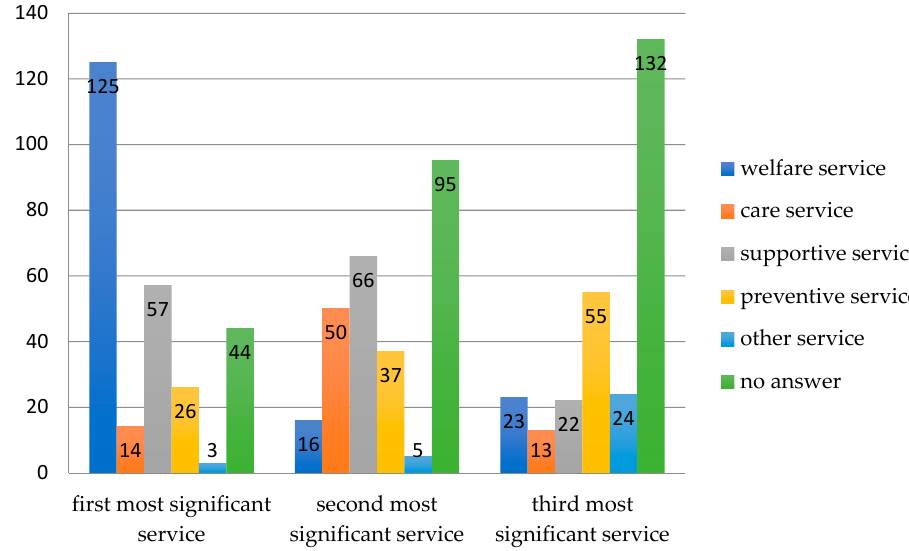
Figure 2. Assessment of the significance of services in the opinion of attendees of day care centres in Poland.